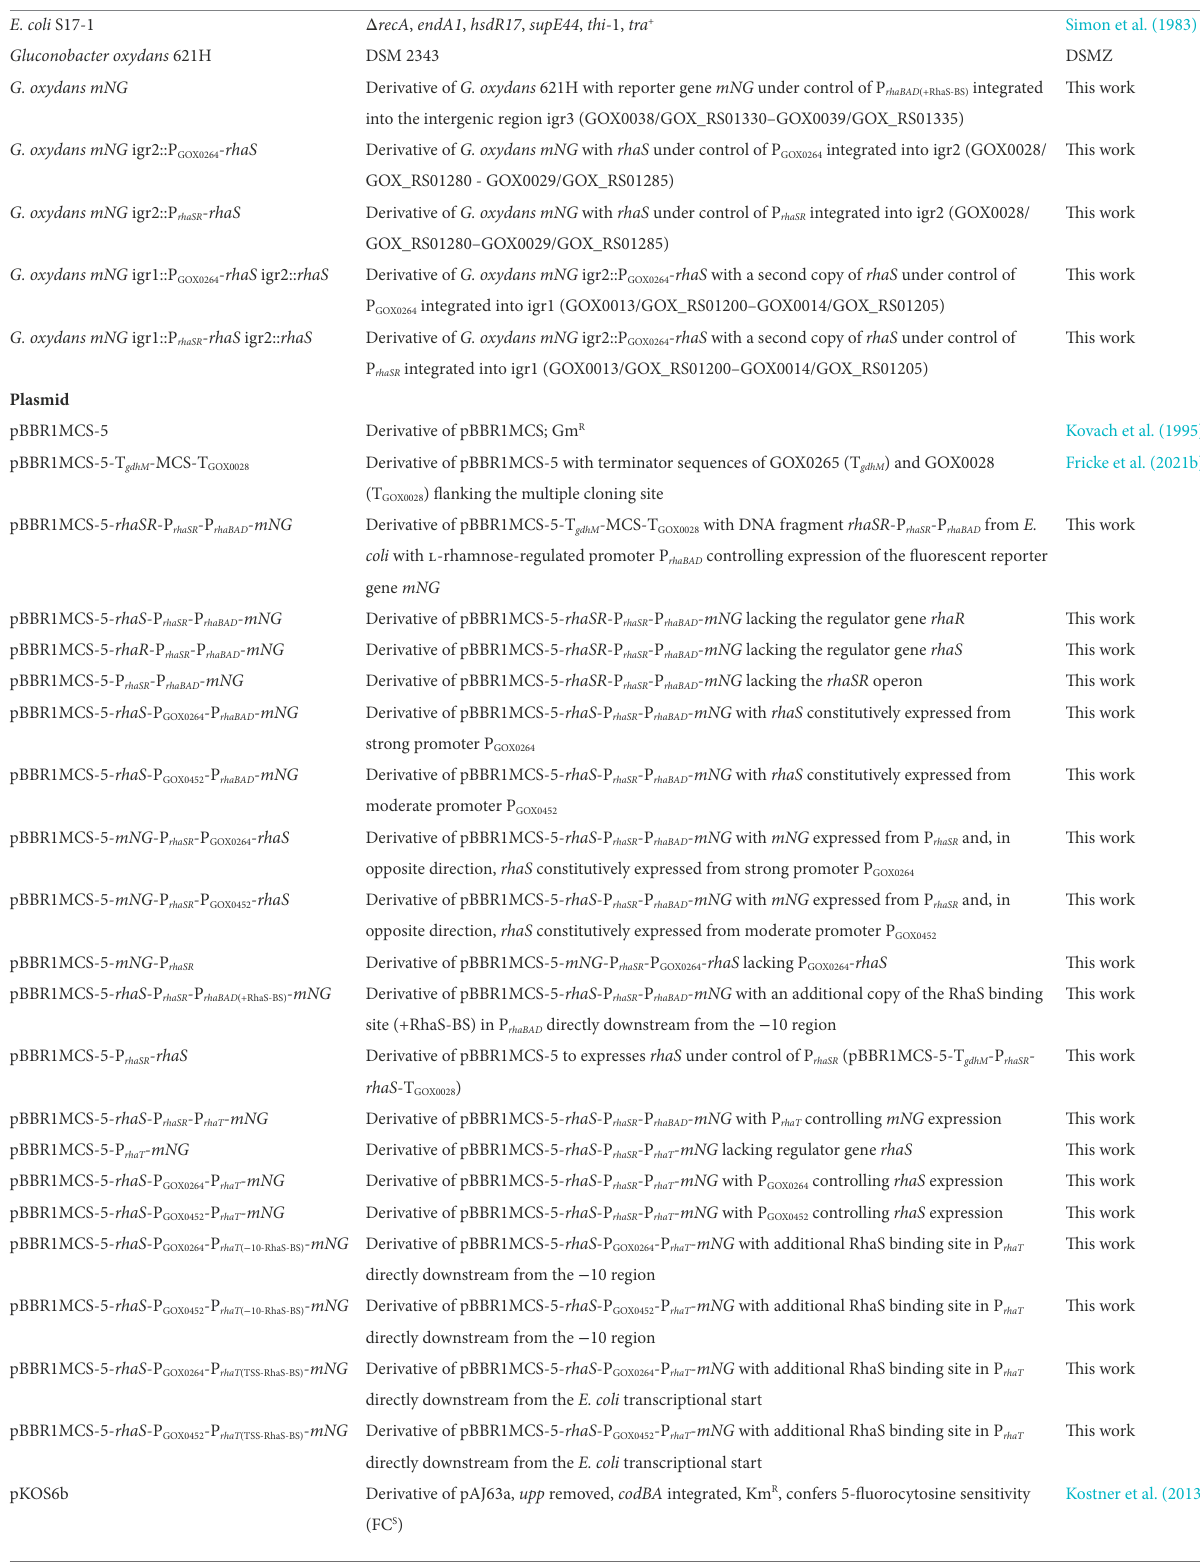
TABLE 1 Strains and plasmids used or constructed in this